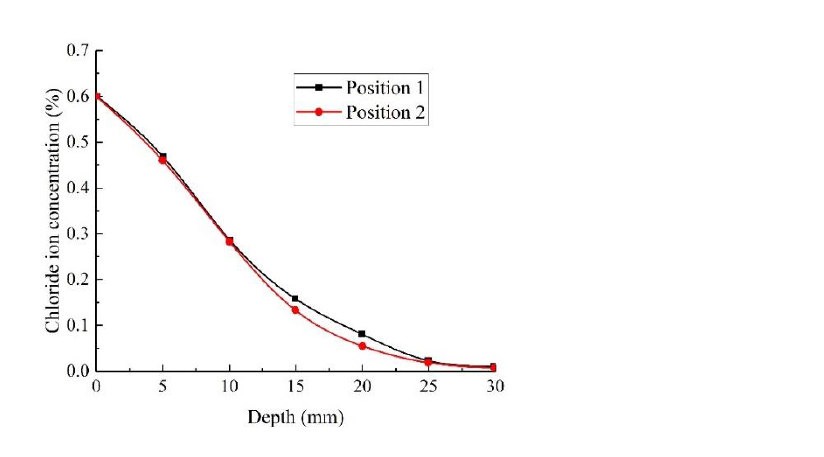
Figure 16. Numerical simulation results of specimens HPC 50 with different aggregate distribution: ( a ) Position 1; ( b ) Position 2.